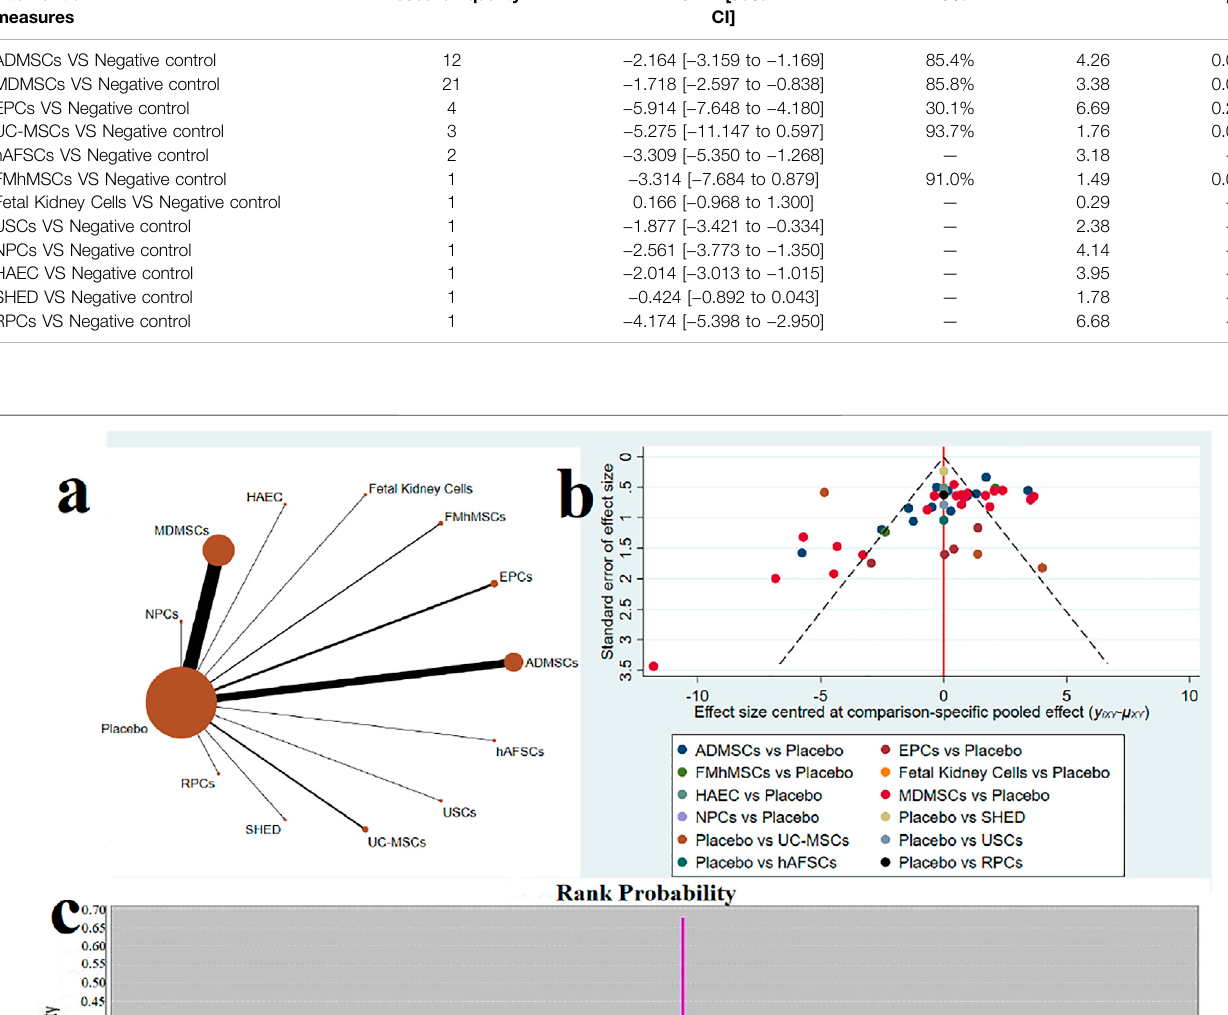
effective to reduce serum creatinine level ( Figure 3C ); ② 7 days after administration: 20 studies were included for data analysis (Donizetti-Oliveira et al., 2012; Changizi- Ashtiyani et al., 2020; Ryoun et al., 2014; Furuichi et al., 2012; Liang et al., 2015; Gupta et al., 2015; Rodrigues et al., 2017; Tian et al., 2017; Havakhah et al., 2018; La Manna et al.,